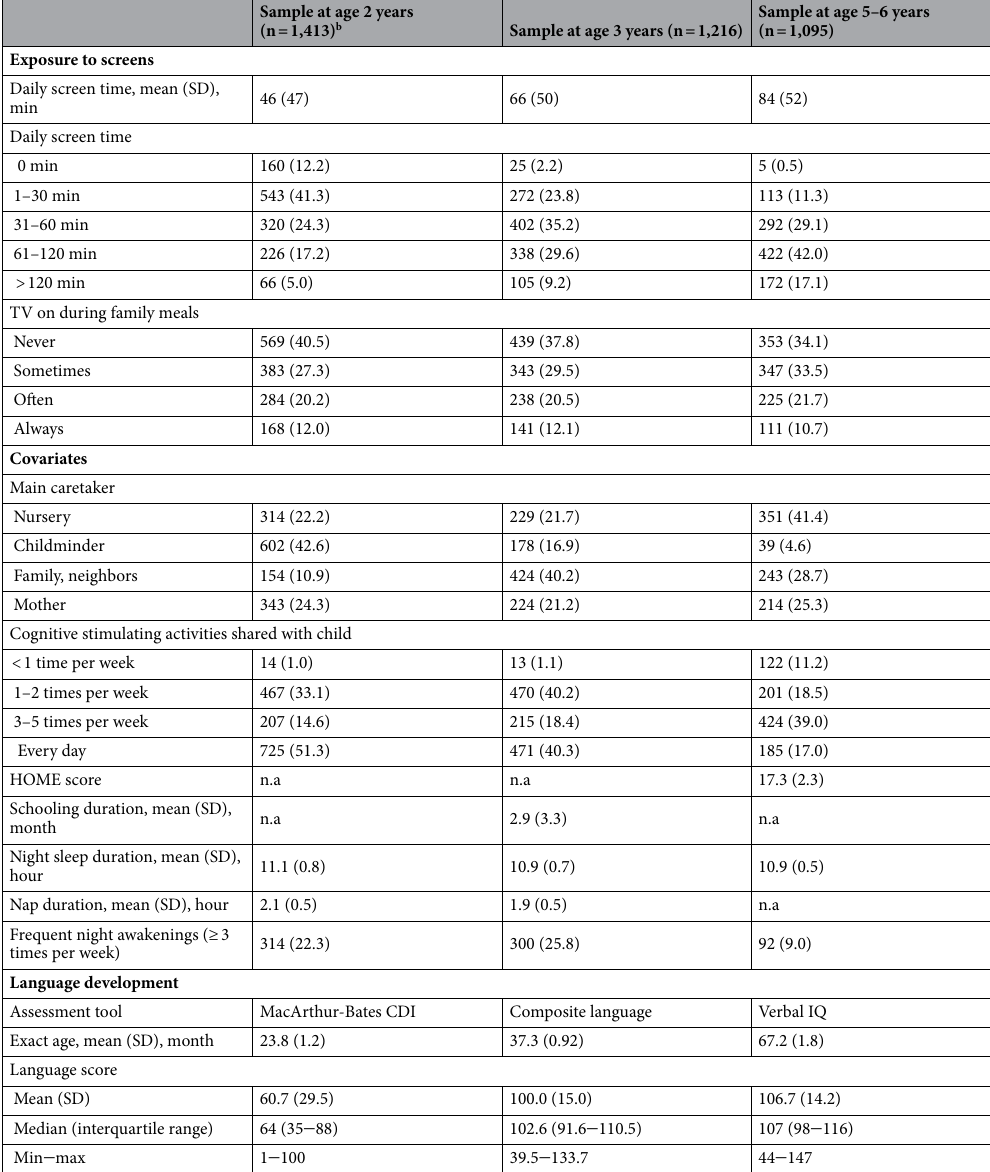
Table 2. Children’s characteristics at ages 2, 3 and 5–6 years in the EDEN cohort a . CDI Communicative Development Inventory, HOME Home Observation Measurement of the Environment, IQ intelligence quotient. a Unless otherwise indicated, data are expressed number (percentage) of participants. b Sample sizes indicated in column headers reflect largest sample size (i.e., the number of children with data for language development); data for exposure to TV and covariates were calculated without imputation for missing data and may be based on smaller sample